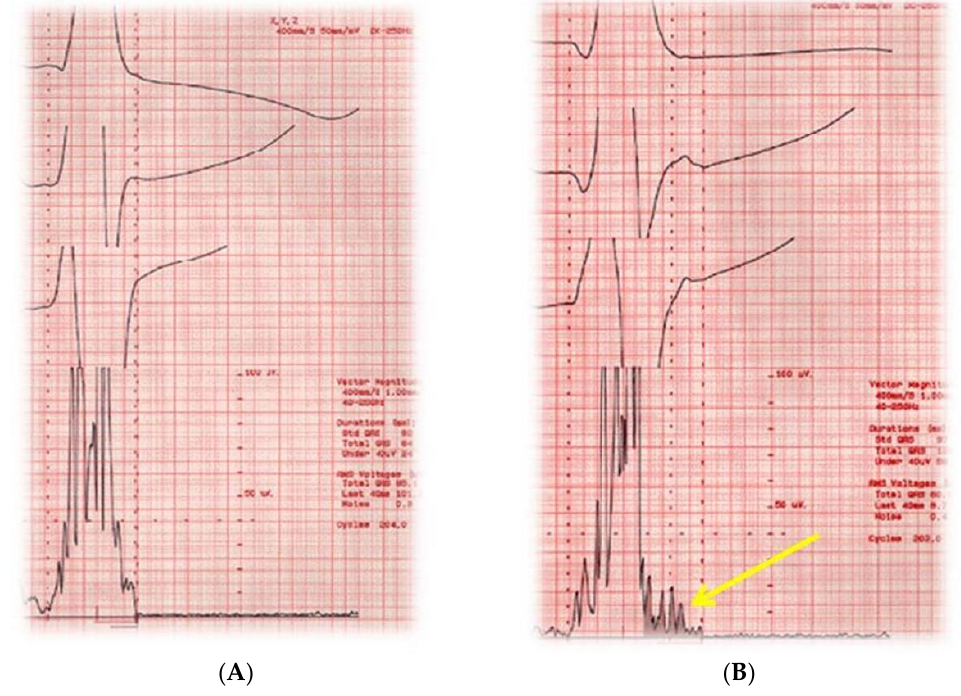
Figure 4. Signal-average ECG of a normal subject ( A ) and a patient with idiopathic dilated cardiomyopathy ( B ). Note the fragmentation of terminal parts of QRS indicative of late potentials (yellow